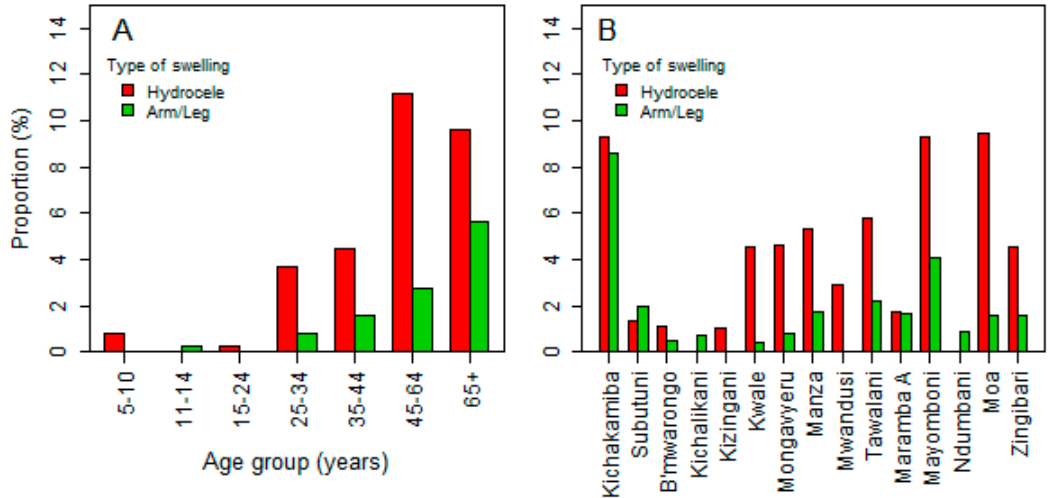
Figure 5. Distribution of hydrocele in males and swelling of arms or legs in both males and females by age group ( A ) and by village ( B ).